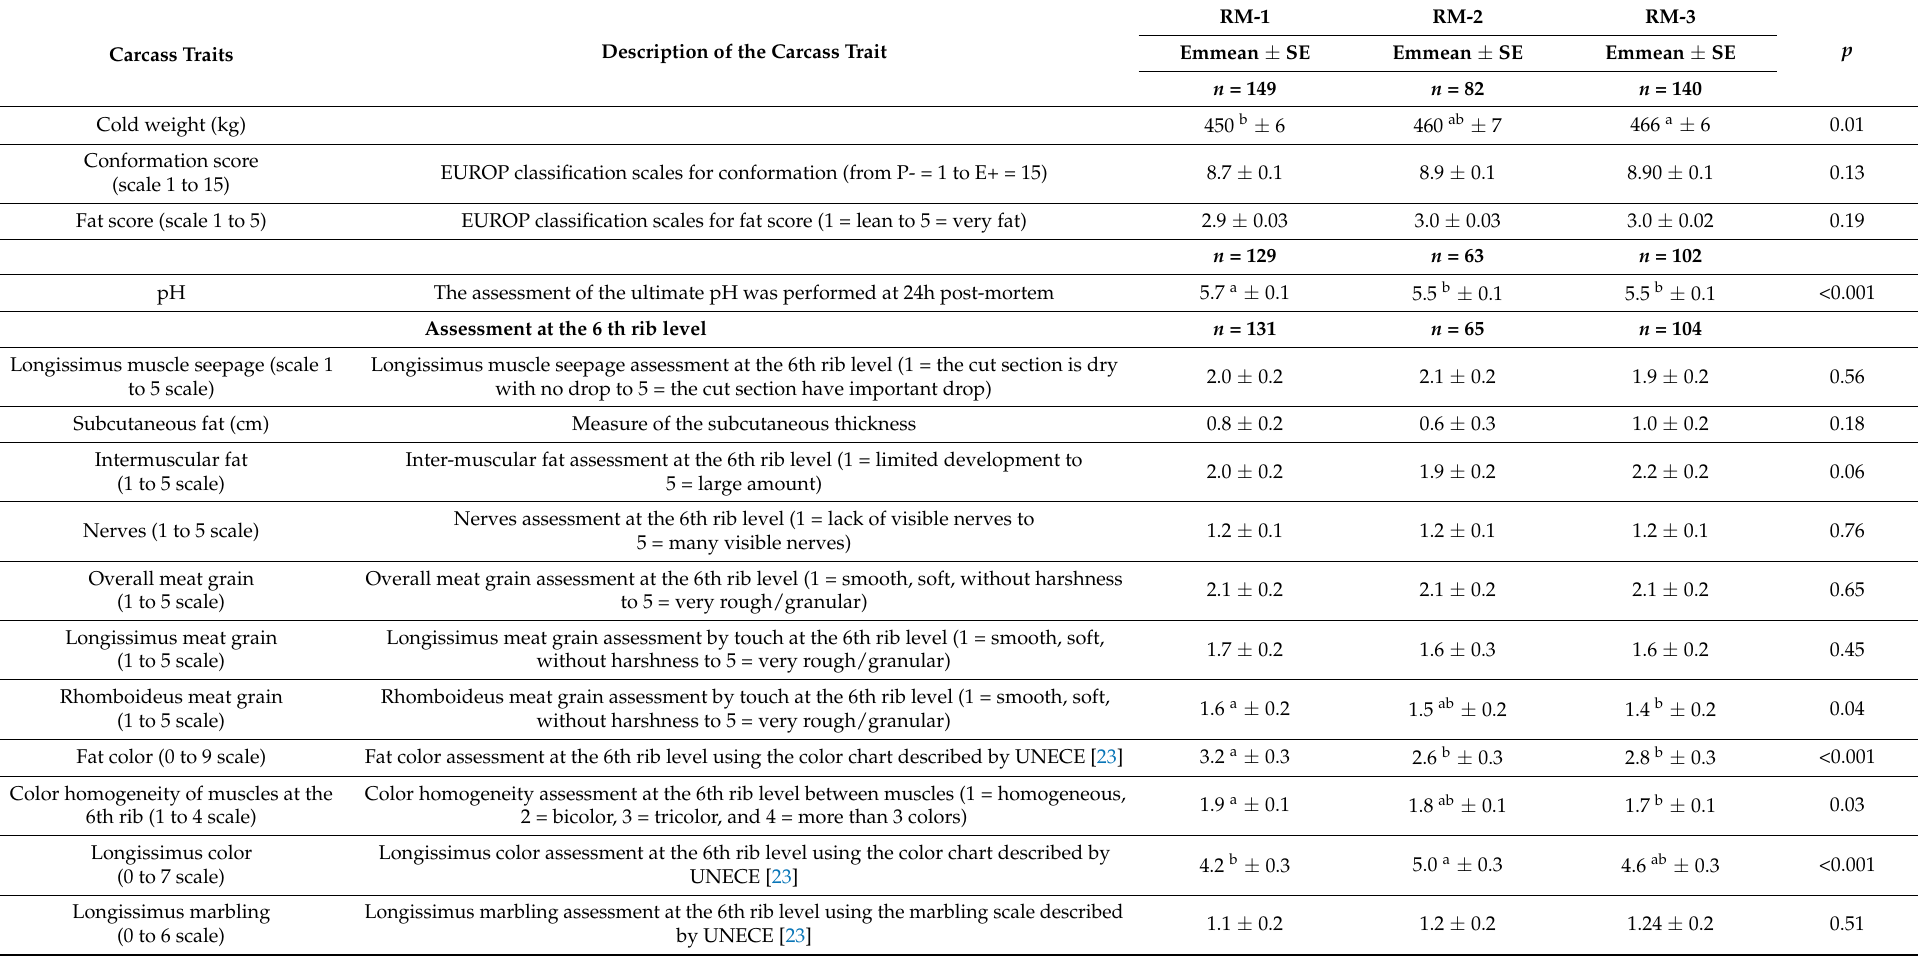
Table 1. Effects of the three rearing managements (RM) applied during the whole cull cows’ life on carcass